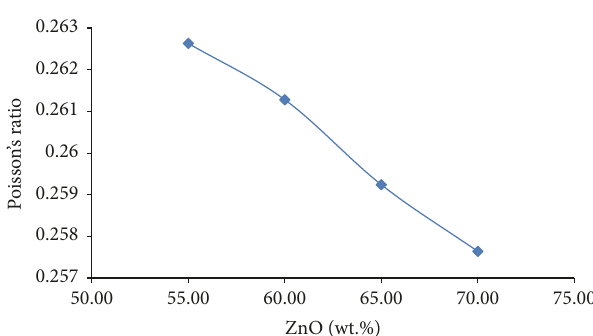
Figure 10: Elastic moduli versus wt.% of ZnO calculated using Rocherulle’s model.